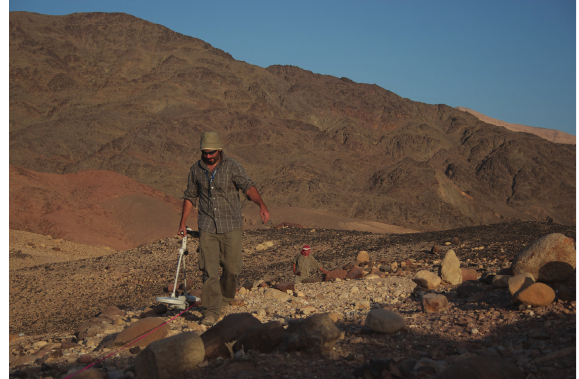
Figure 2: Operator follows the string to ensure straight profiles on the slopes of the site of Khirbat Faynan, Jordan. The instrument (photo, M. L. Vincent, UCSD Levantine Archaeology Lab) is kept at a constant distance from the ground